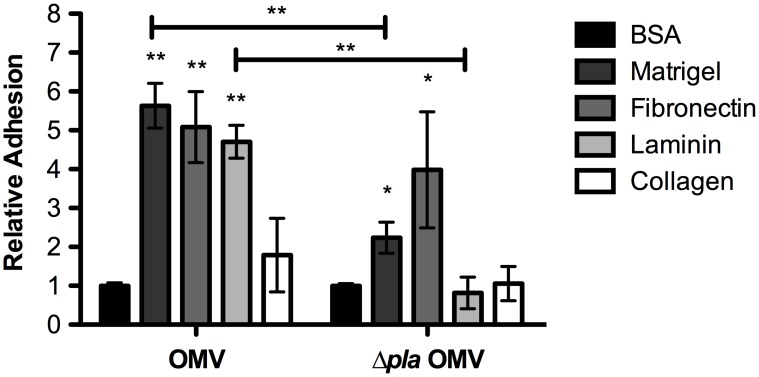
Binding of Y. pestis OMVs to components of the extracellular matrix.Wild-type or Δpla OMVs were examined by ELISA for the ability to bind the ECM components Matrigel, fibronectin, laminin, and collagen. BSA was used as a negative control for binding and differences in fluorescence are presented as fold change compared to BSA (set at 1). The combined mean and SE of 3 independent experiments are shown. *p<0.05, **p<0.005 (two-way ANOVA).